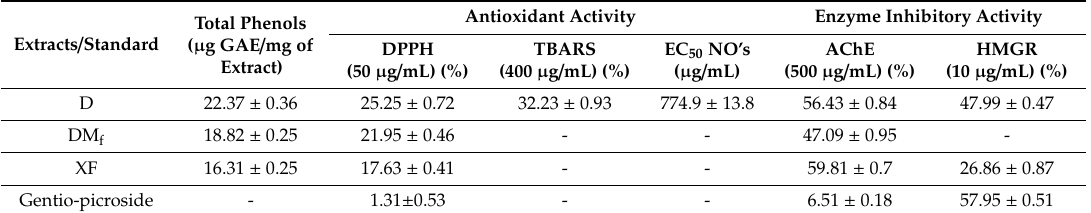
Table 2. Total phenols and bioactivities of the complete decoction (D) of C. erythraea , the